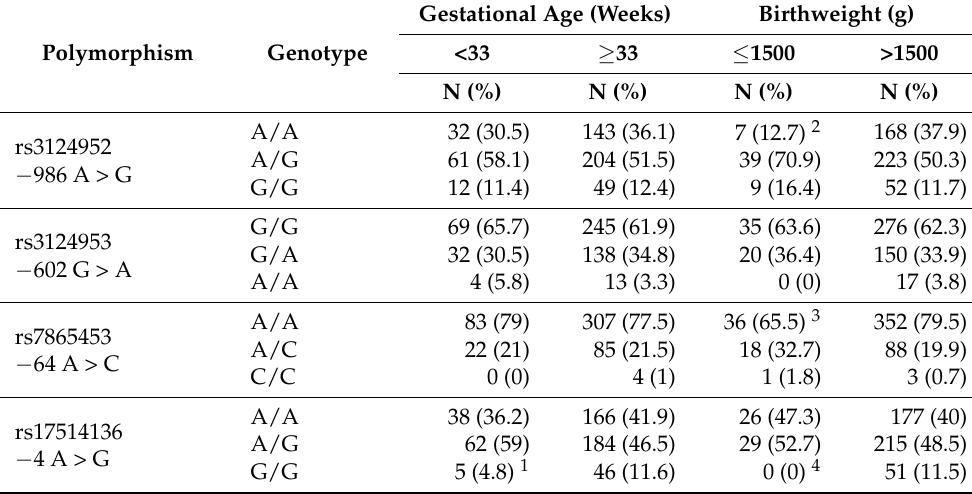
Table 2. Distribution of genotypes associated with FCN2 gene promoter polymorphisms in preterm newborns, depending on gestational age and